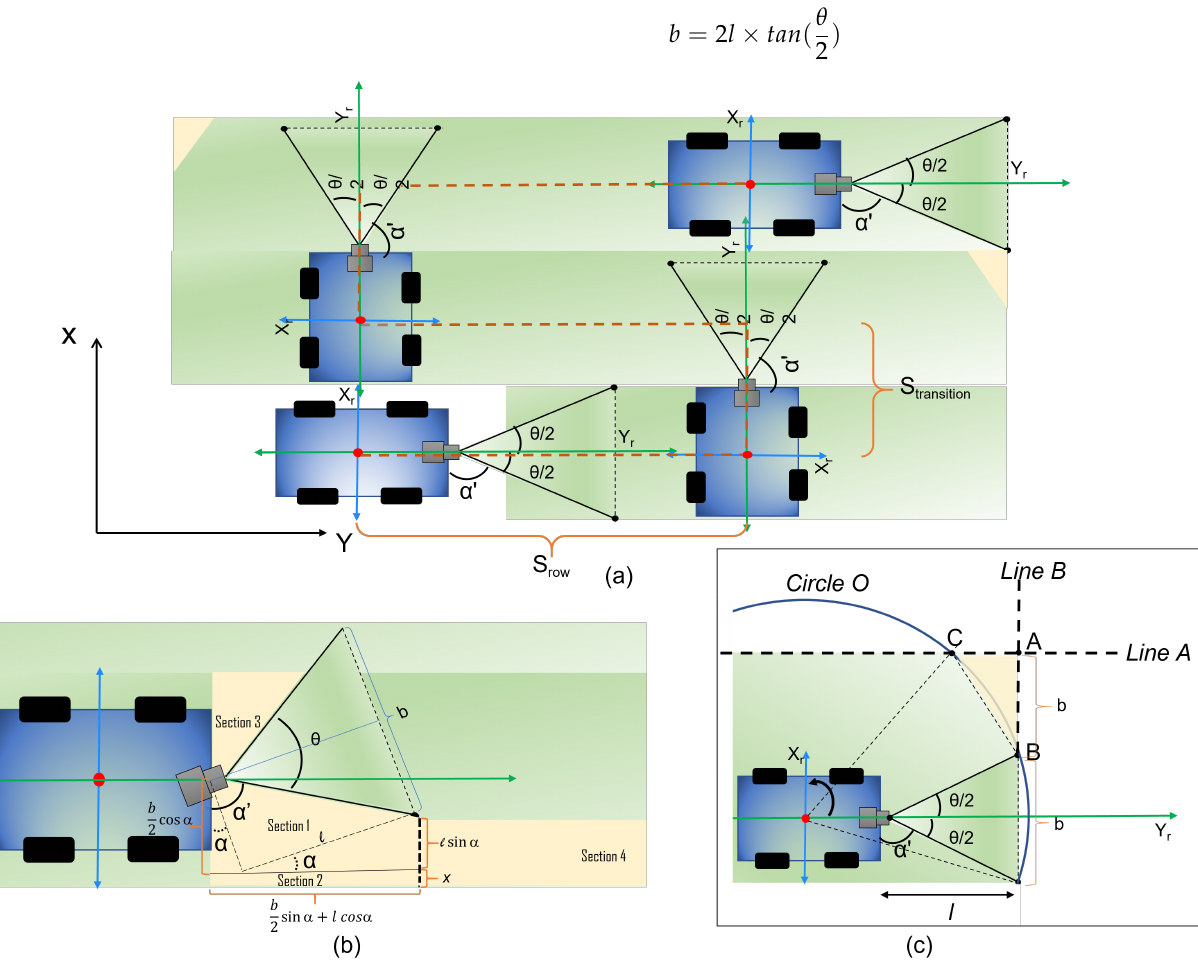
Figure 4. The zig-zag area coverage strategy of the robot ( a ), area missed during the initial stage of operation ( b ), area missed at the turning ( c